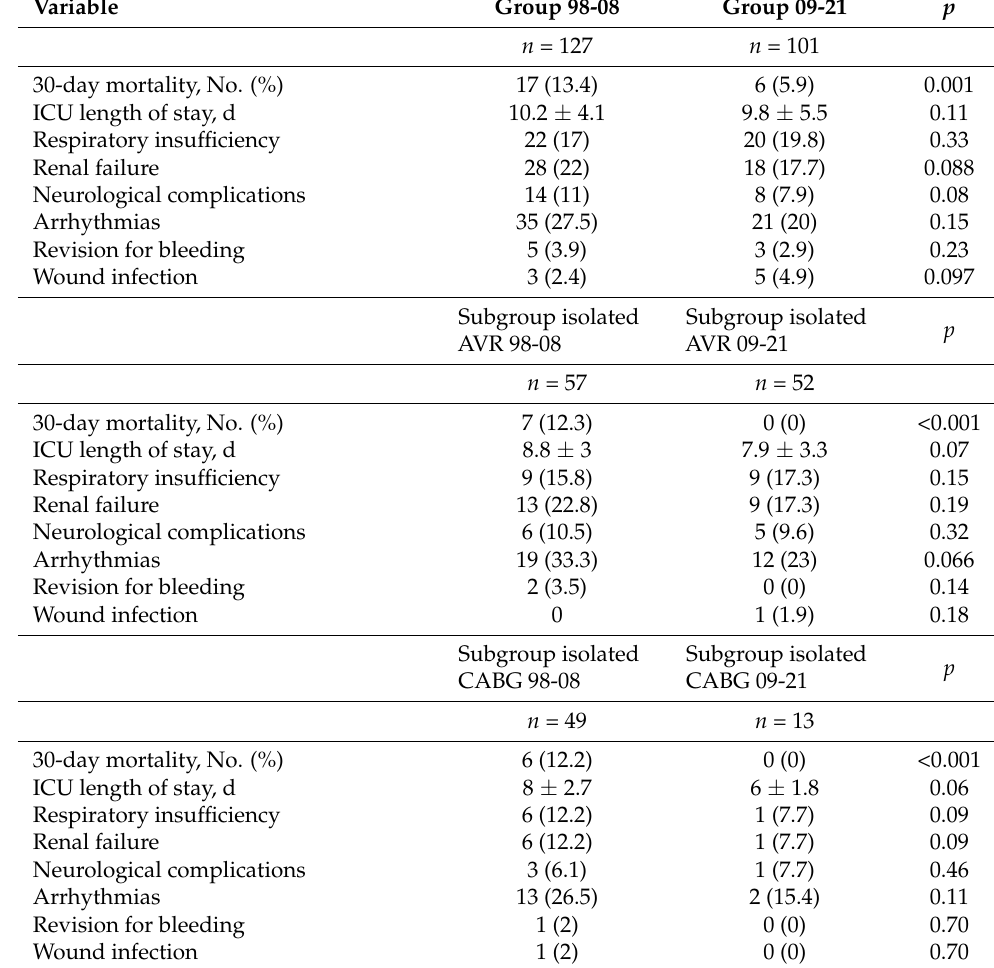
Table 3. Postoperative